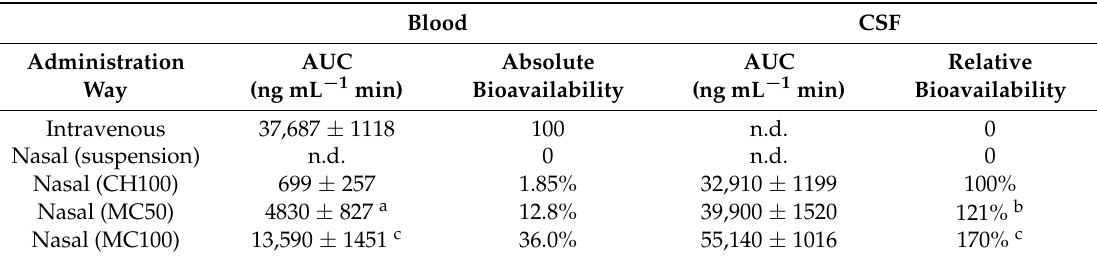
Table 3. Area under concentration curves (AUC) obtained after CPA administration in rats for blood and CSF compartments.